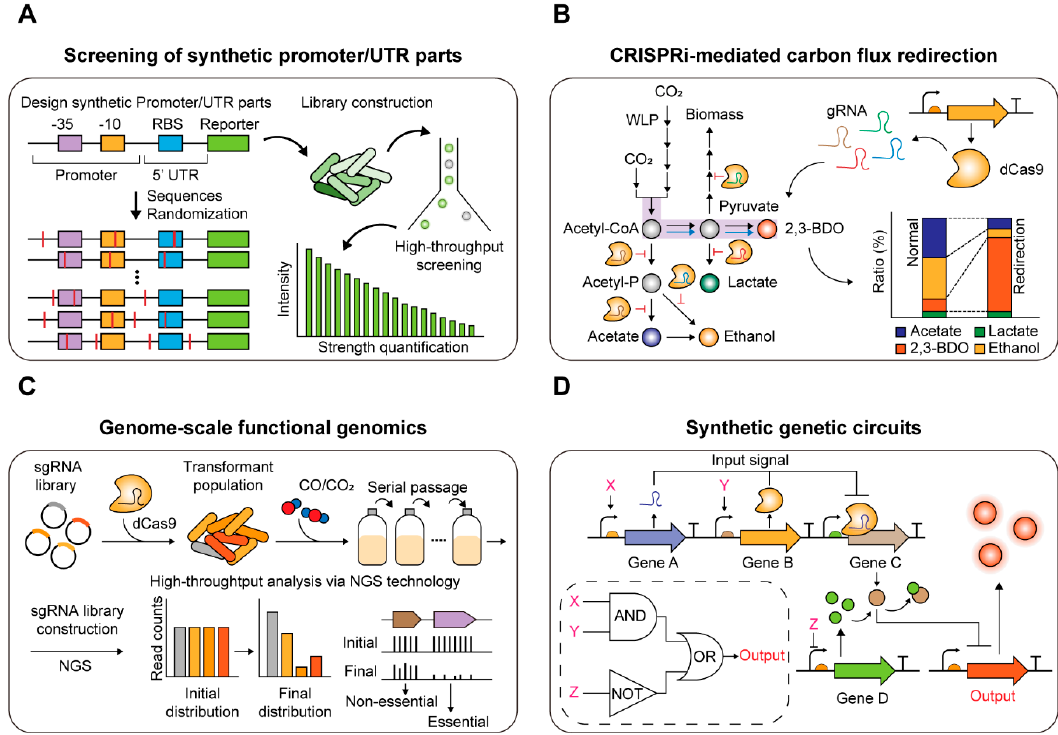
Figure 3. Synthetic biology approach to develop chassis microbe strain. ( A ) High-throughput screening of synthetic promoter/UTR parts. ( B ) Carbon flux redirection towards desired products through CRISPRi-mediated repression of genes in competing pathways. ( C ) Genome-wide CRISPRi/a screening for functional genomics studies. ( D ) Introduction of synthetic genetic circuits; Genetic regulation system using AND, NOT, and OR gate.